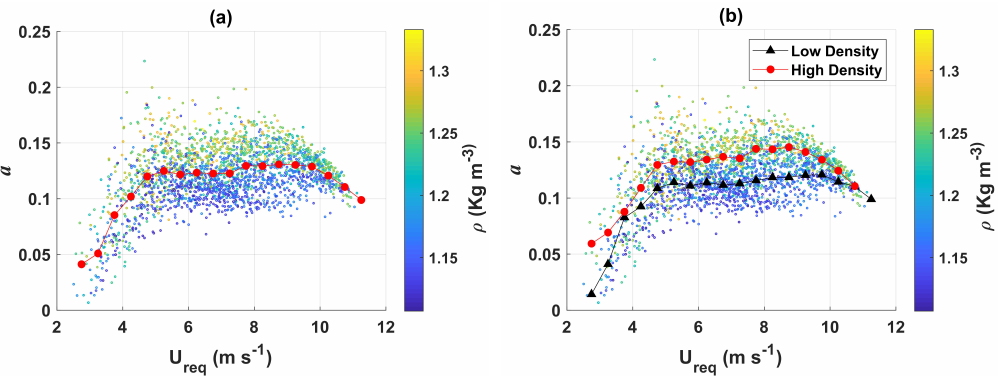
Figure 14. ( a ) Induction curve resulting from values of C z found for different stability regimes and then dividing axial flow induction factor values into bins of 0.5 m s − 1 for U req and ( b ) two induction curves resulting from division of data into two smaller sets based on air density.